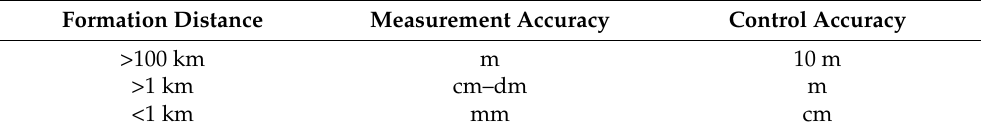
Figure 7. Schematic diagram of the Gemini project. Table 5. Gemini accuracy indicators.